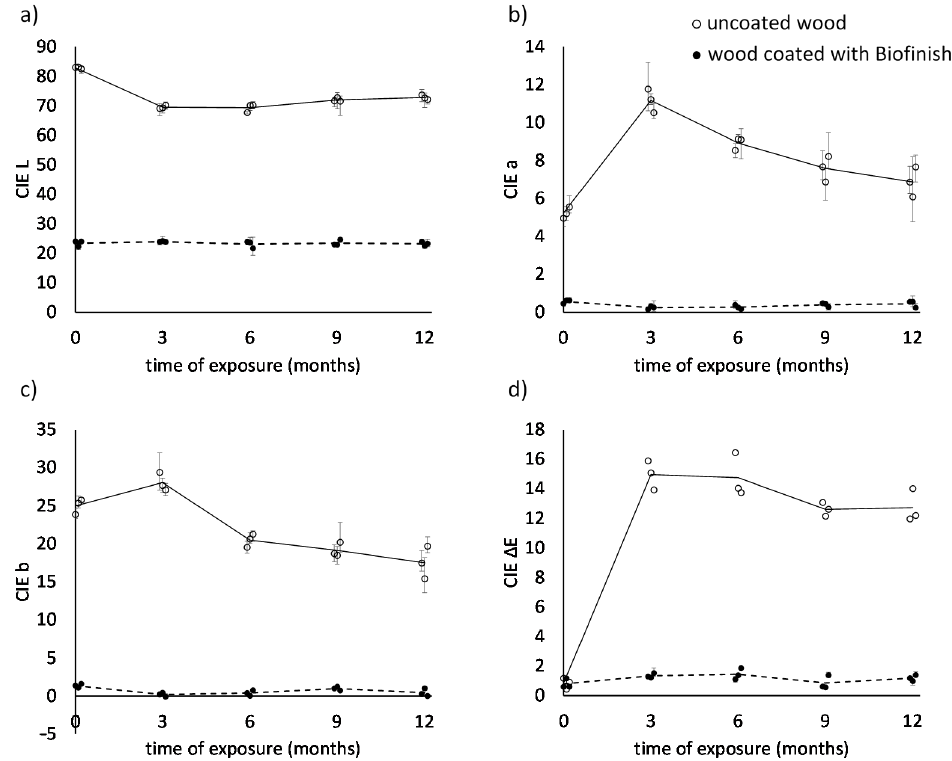
Figure 3. CIE L * a * b * colour coordinates of uncoated Scots pine and wood coated with biofinish as a function of exposure time. Note: Error bars correspond to the range (minimum–maximum) of results observed: ( a ) CIE L *, ( b ) CIE a* , ( c ) CIE b* , ( d ) CIE Δ E .